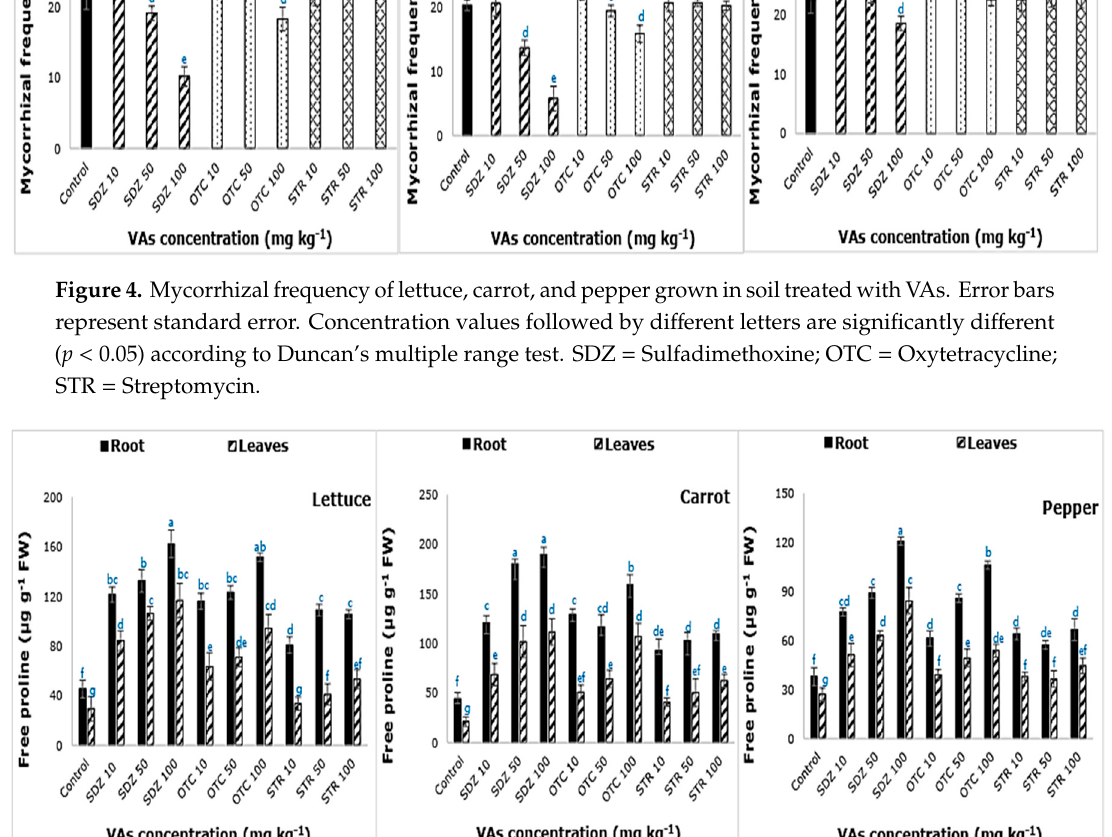
Figure 5. Free proline content of lettuce, carrot, and pepper grown in soil treated with VAs. Error bars represent standard error. Concentration values followed by different letters are significantly different ( p < 0.05) according to Duncan’s multiple range test. SDZ = Sulfadimethoxine; OTC = Oxytetracycline; STR = Streptomycin.